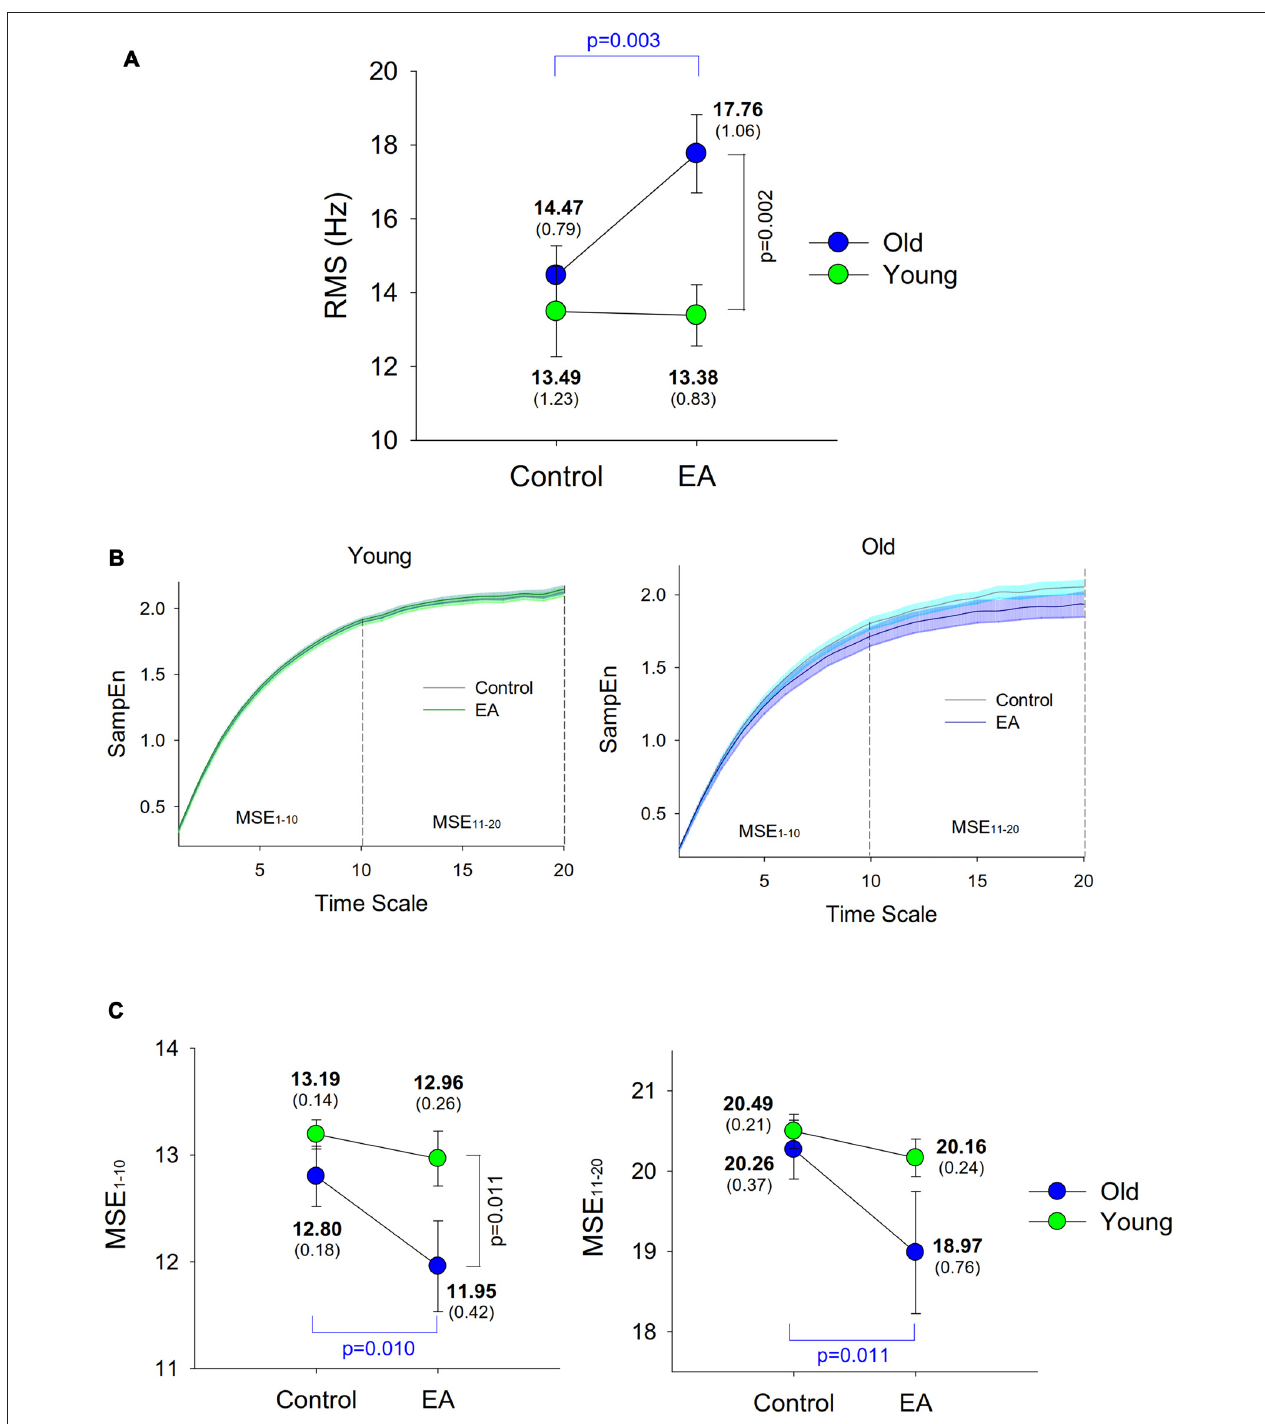
FIGURE 4 | Population means and standard errors for parametric variables of cumulative discharge rate in the control and EA conditions. (A) RMS; (B) MSE; (C) MSE area of low (1–10) and high (11–20) time scales. Each time scale of the MSE curve is 10 ms, corresponding to down-sampling rate of 100 Hz.